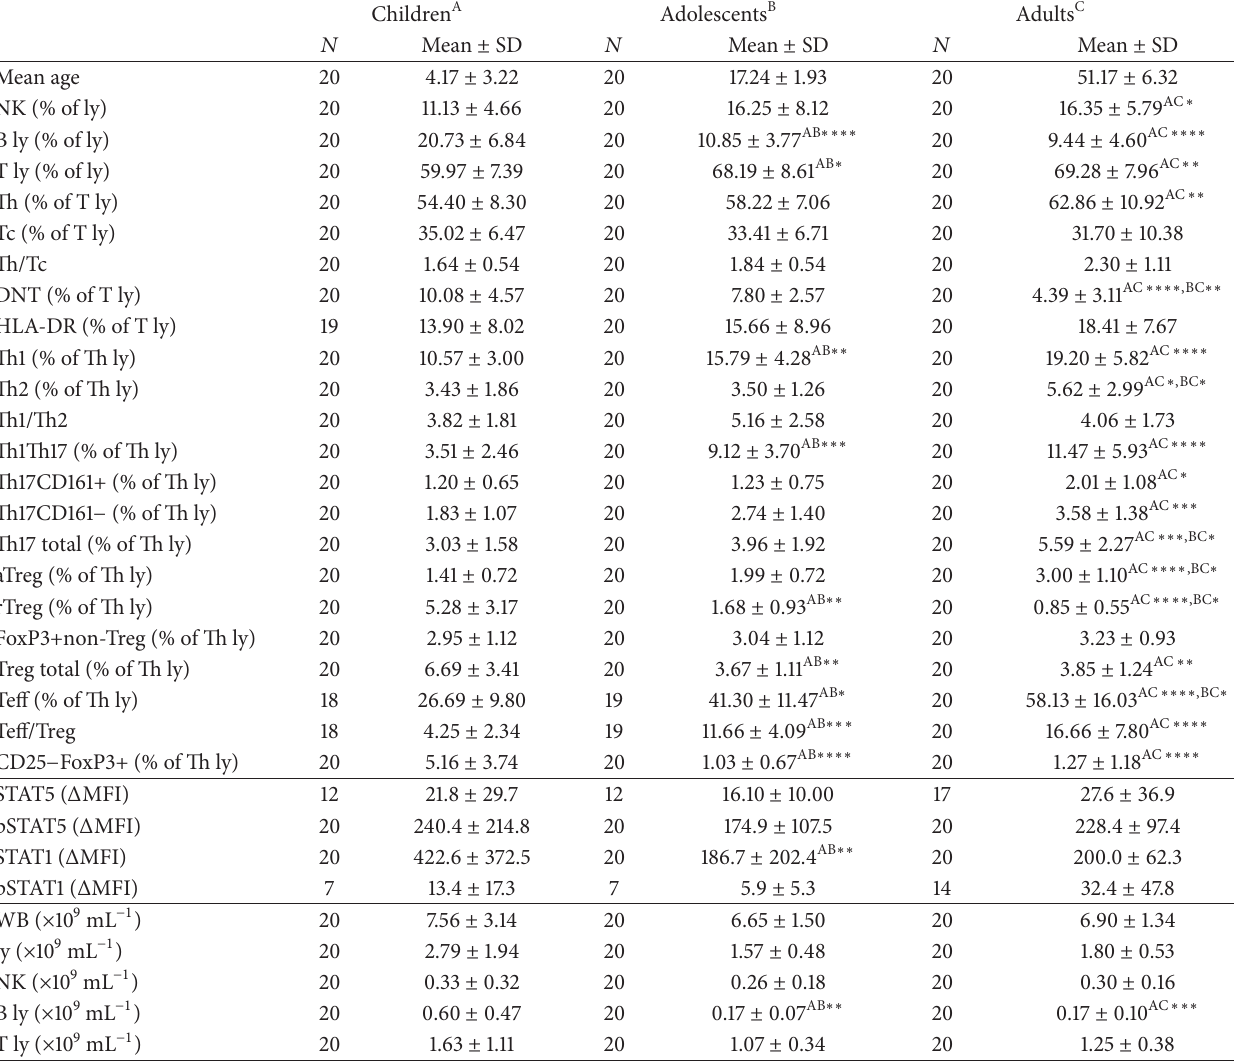
Table 2: Studied cell subsets in all three age groups of healthy subjects analysed by flow cytometry ( ∗ 𝑃 < 0.05 ; ∗∗ 𝑃 < 0.01 ; ∗∗∗ 𝑃 < 0.001 ; ∗∗∗∗ 𝑃 < 0.0001